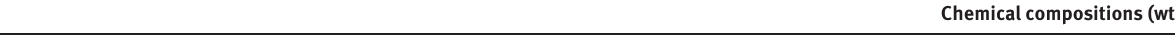
Figure 1 Microstructures of the base metals. (A) W-Cu alloy. (B) 18-8 stainless steel. Table 1 Chemical compositions of 18-8 stainless steel and Cu-Mn-Co brazing